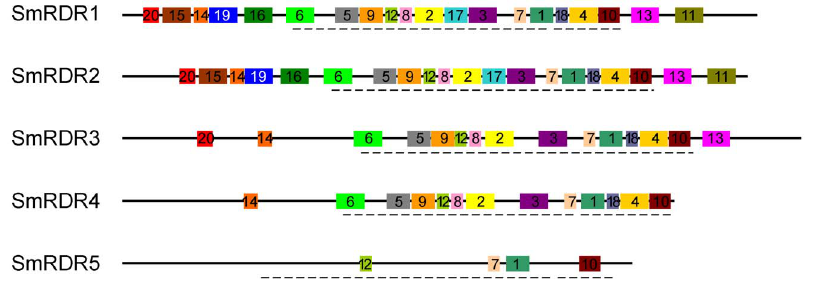
Figure 3. Conserved motifs of SmRDRs proteins identified with the MEME search tool. Motifs are represented by boxes. The numbers (1– 20) and different colors in boxes represent motif 1–motif 20, respectively. Box size indicates the length of motifs. Broken lines indicate locations of the RdRp domain.